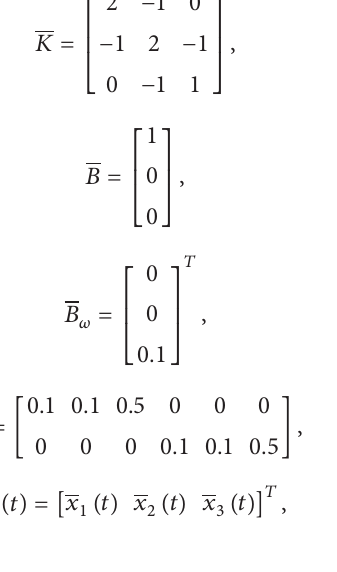
Figure 1: Disturbance input signal.